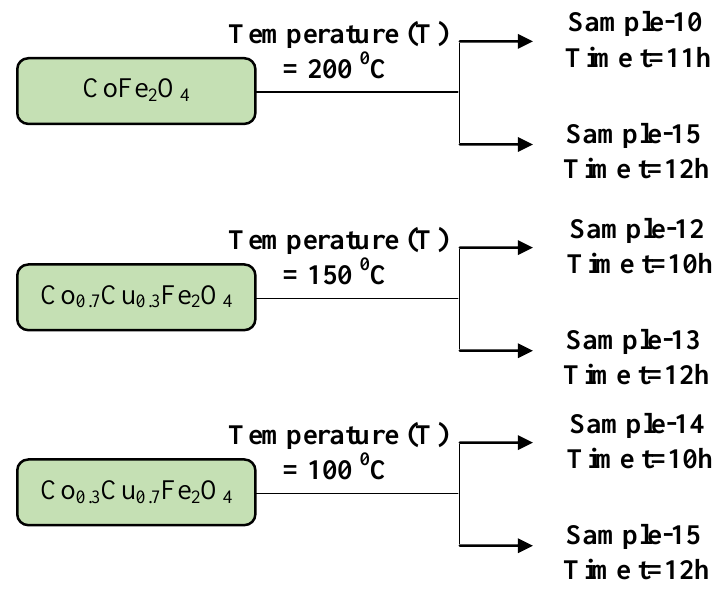
Fig.4: The diagram of the second step hydrothermal synthesis conditions.